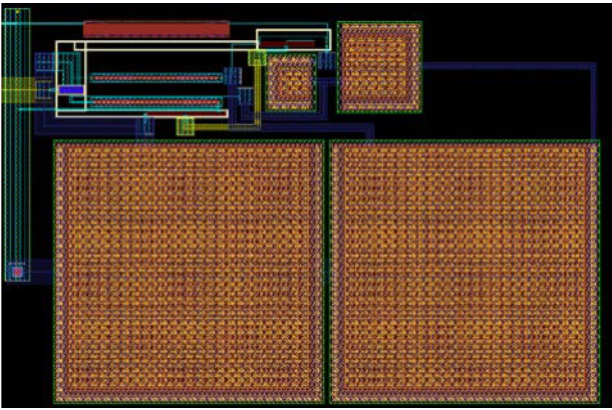
Figure 7. Time-domain simulation results of the WuR with amplification and low-pass filtering stages. AM input signal (V rf ) ( a ), the output of the first stage (V in ) ( b ), and the output of the second stage (V out ) ( c ).